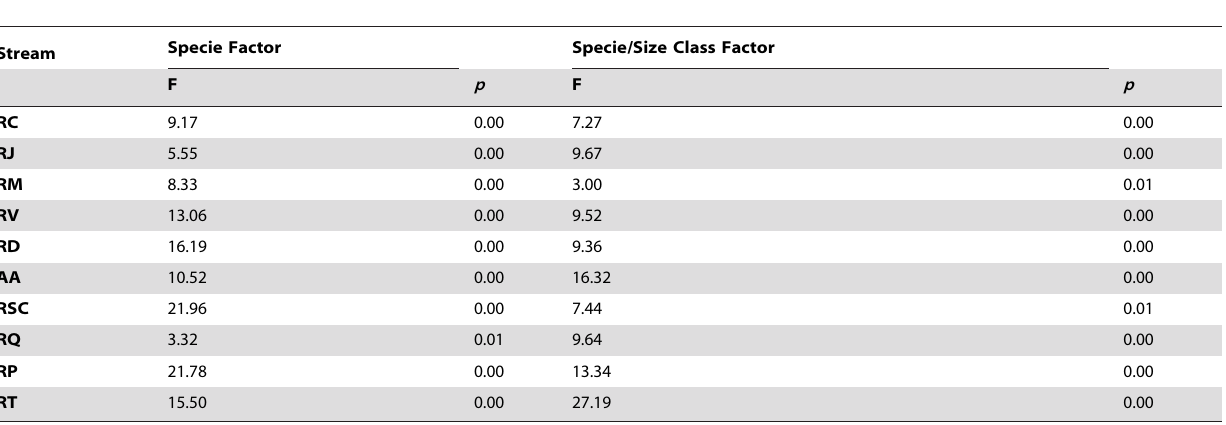
Table 2. Permutational Multivariate Analysis of Variance results of each sampling stream in the Alto Jacuı´ sub-basin.